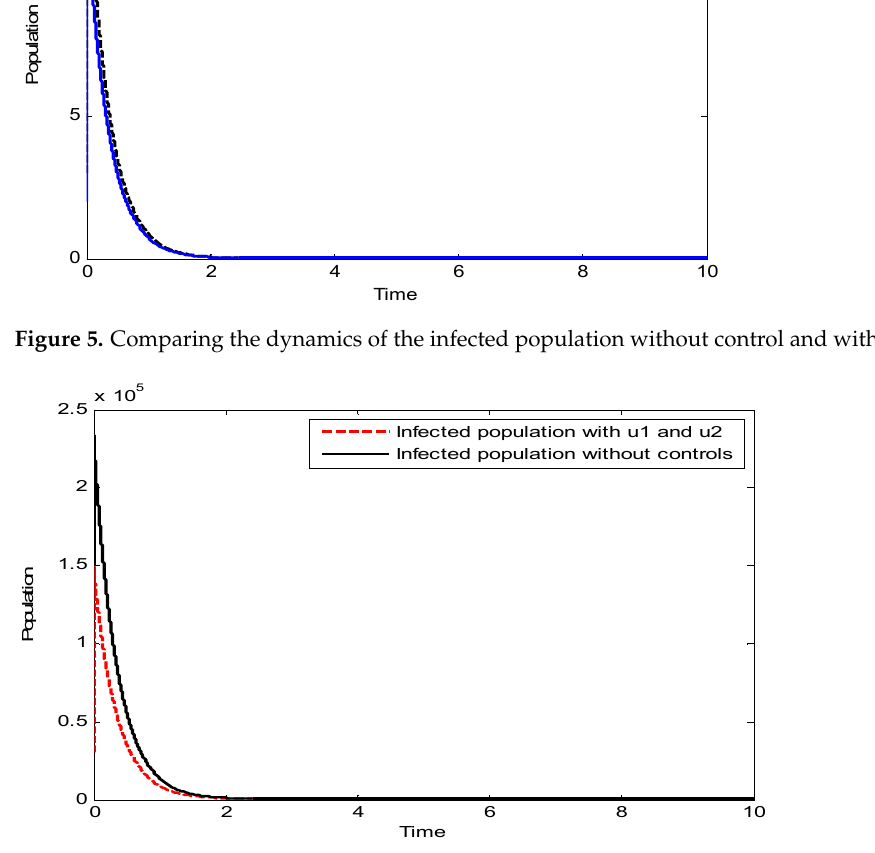
Figure 5. Comparing the dynamics of the infected population without control and with control 𝑢 (cid:2871) .